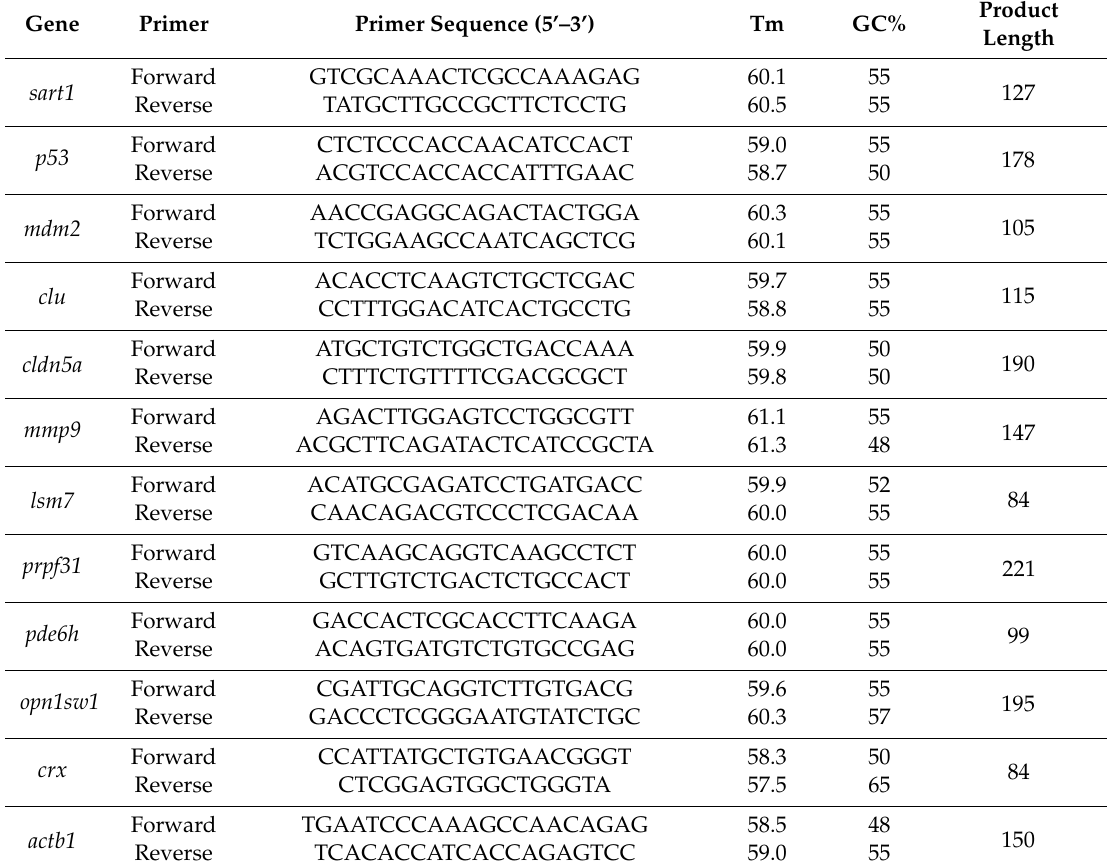
Table 2. Primer sequences for